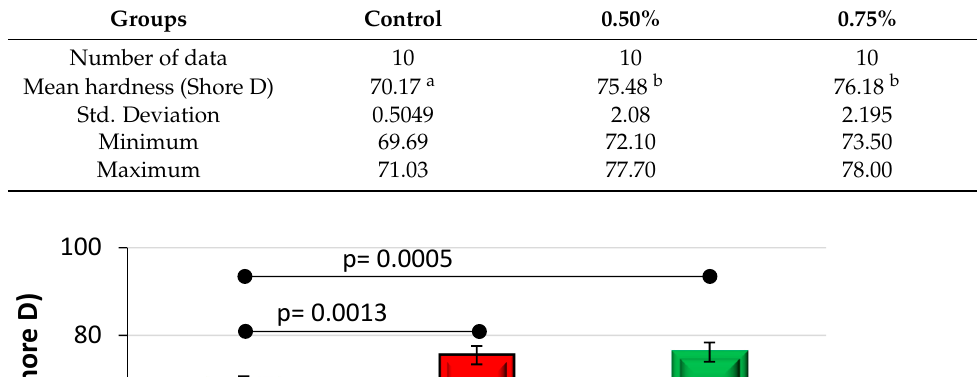
Figure 8. Bar chart showing mean values of the surface hardness in the HC acrylic resin incorporated with Ag-Zn zeolite at different concentrations (0.50 wt.% and 0.75 wt.%) and without any Ag-Zn zeolite (control group). Horizontal lines connecting two bars show statistical significance ( p < 0.05).